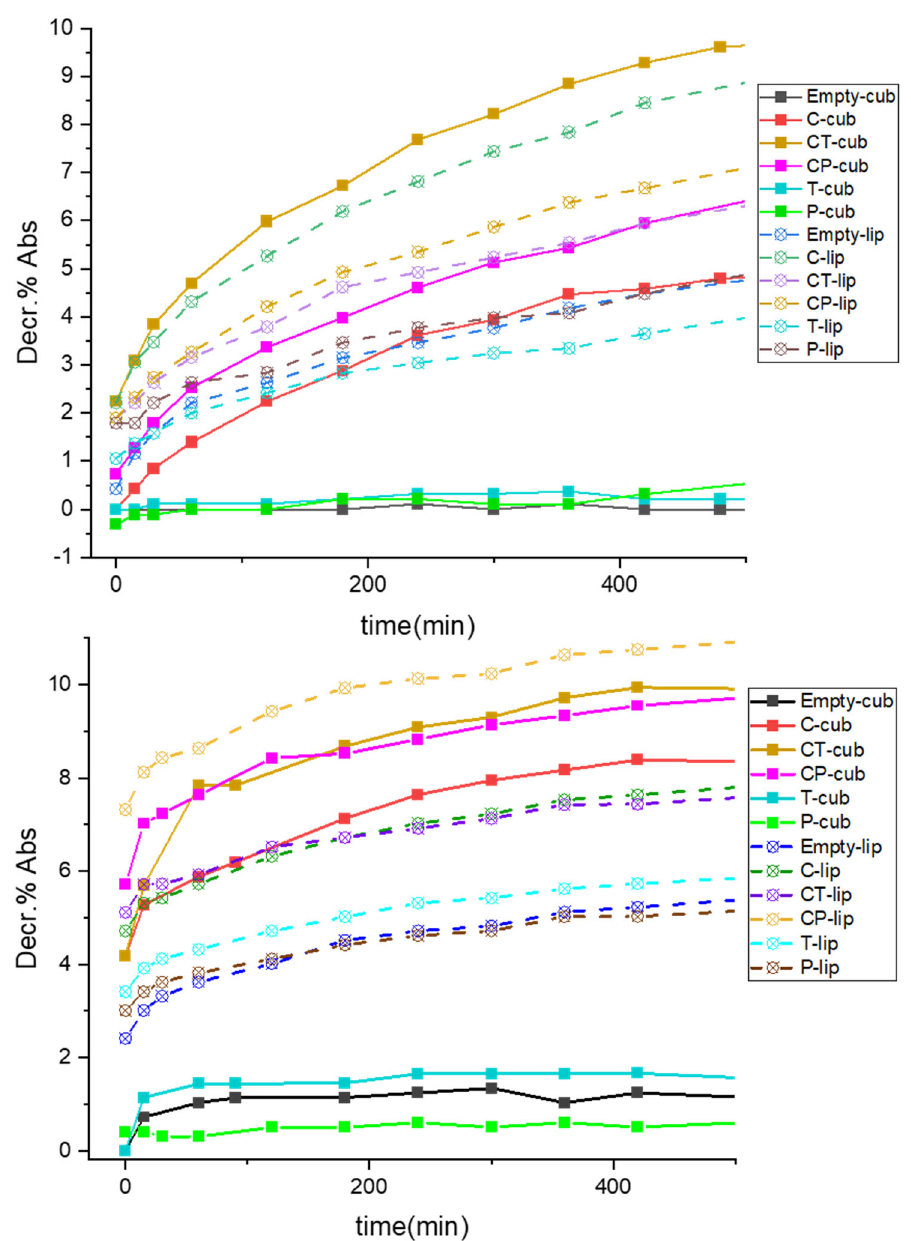
Figure 2. Kinetic of decrement of absorbance for sample in standard (i.e., unbroken) conditions, solid squares for cubosomes, empty circles for liposomes, ( up ); and in disrupted conditions, solid squares for cubosomes, empty circles for liposomes ( down ).